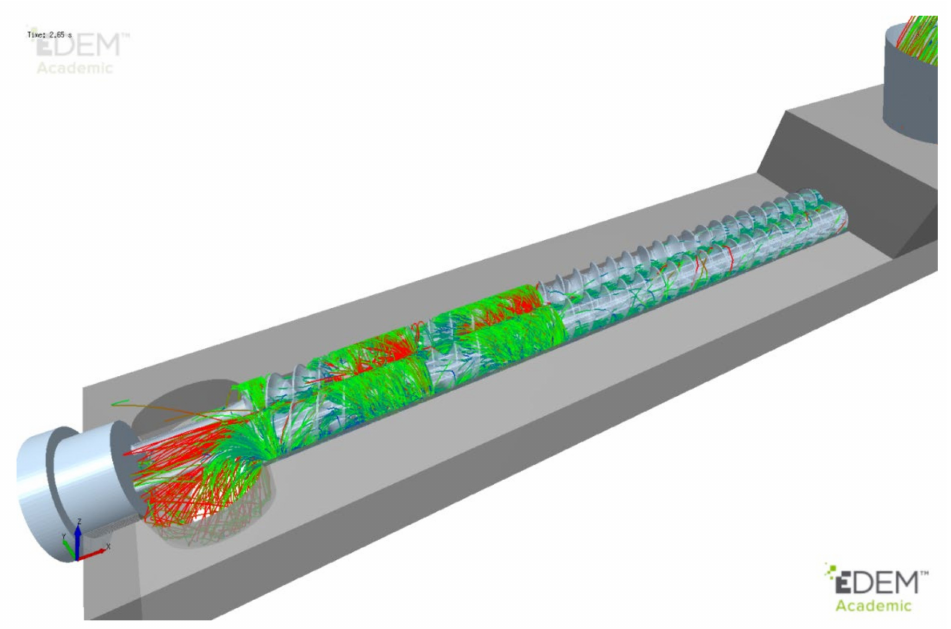
Figure 6. Particle streamlines for full granulator. Cross-sections of the temporally (5 screw revolutions) and spatially averaged solid fraction are shown in Figure 7 for the two main element types: conveying and kneading elements. The figure shows that there are three main transport locations for the conveying element: between the screws in the intermeshing zone and at the bottom of each screw bore. The kneading elements show a different pattern due to their flat nature and tend to only push particles around the plane of the element. The DEM simulations predict more material in one bore of the conveying elements, where the driving screw is located, than the other. This matches previous experimental observations [76].